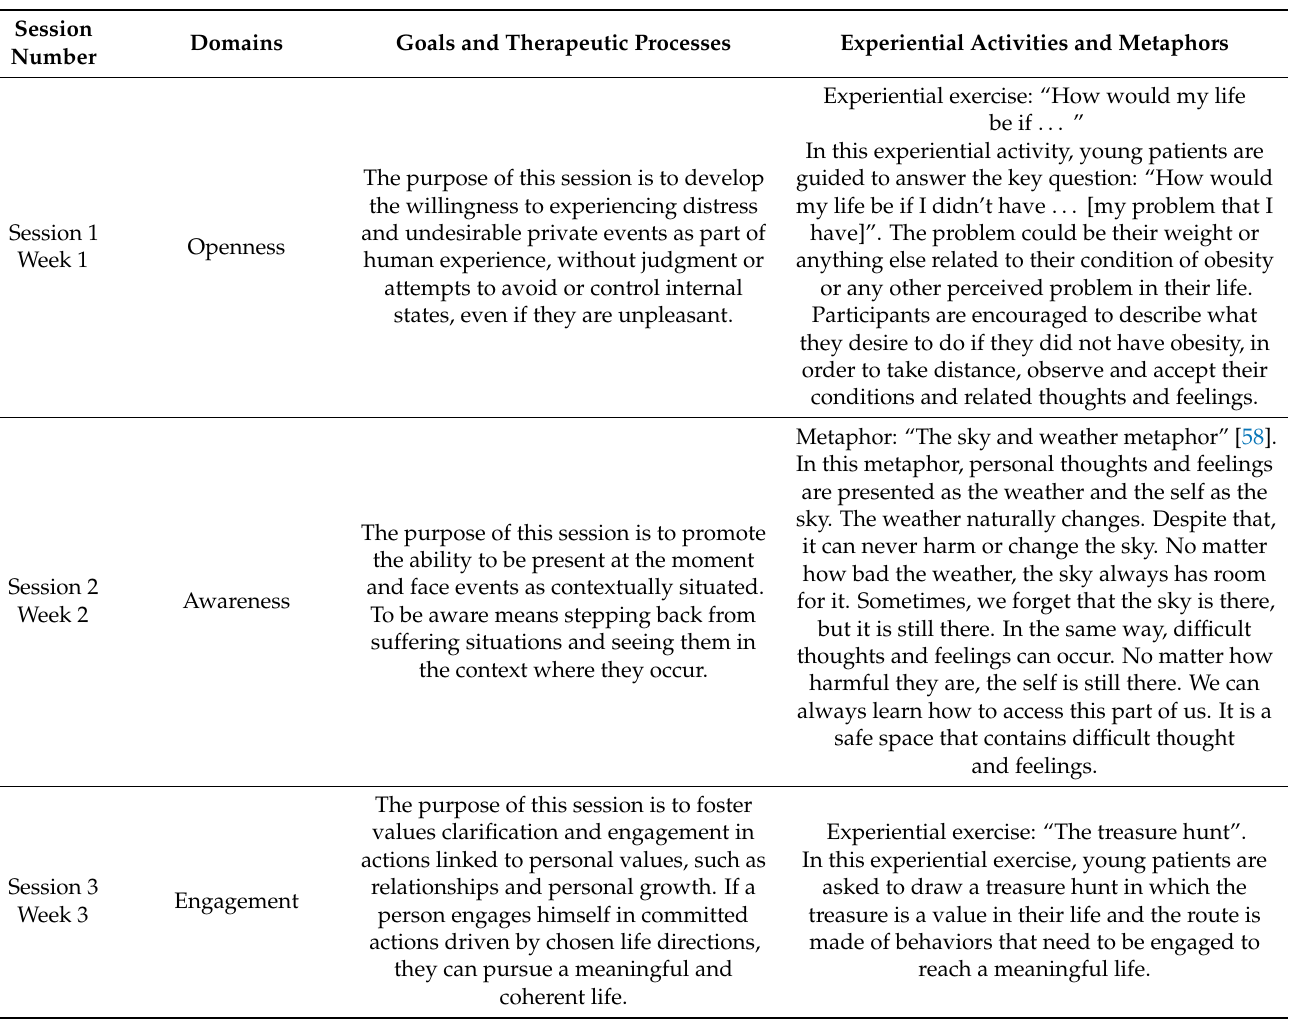
Table 1. The ACT-based